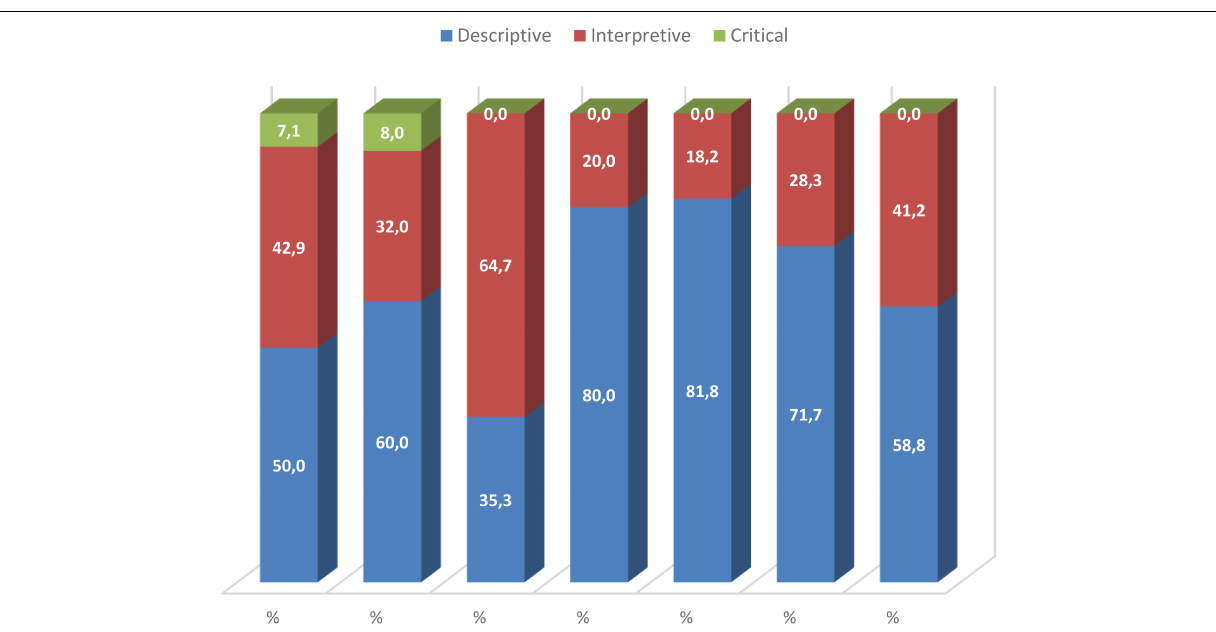
FIGURE 3 | Descriptive, interpretive, and critical